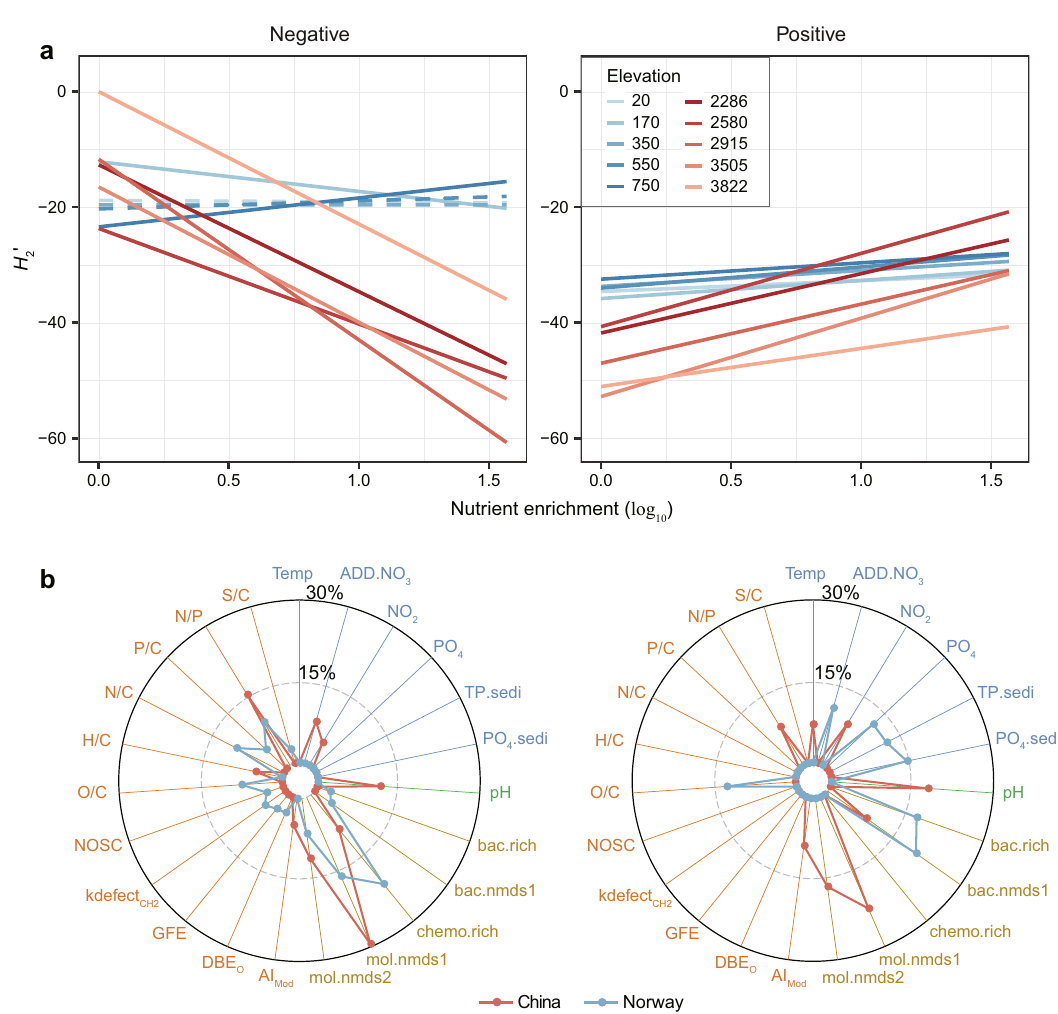
Fig. 5 Relative importance of diversity and molecular traits in explaining specialization of DOM-bacteria networks. a We plotted specialization H 2 ′ against nutrient enrichment for negative (left panel) and positive (right panel) bipartite networks for each elevation in China (red lines) and Norway (blue lines). Statistical signi fi cance of linear model fi ts with one-sided F-statistics was indicated by solid ( P ≤ 0.05) or dotted ( P > 0.05) lines. For better visualization, we omitted the data points but detailed scatter plots and statistics are shown in Fig. S14. b We examined the relative importance of all explanatory variables on the H 2 ′ of negative (left panel) and positive (right panel) bipartite networks in China (red lines) and Norway (blue lines) using random forest. The relative contribution (%) of each variable towards H 2 ′ is shown in radar plots. The explanatory variables were grouped by environment, energy, diversity and traits with consistent colours of ovals or rectangles as in Fig. 6a. Abbreviations of explanatory variables are detailed in Table